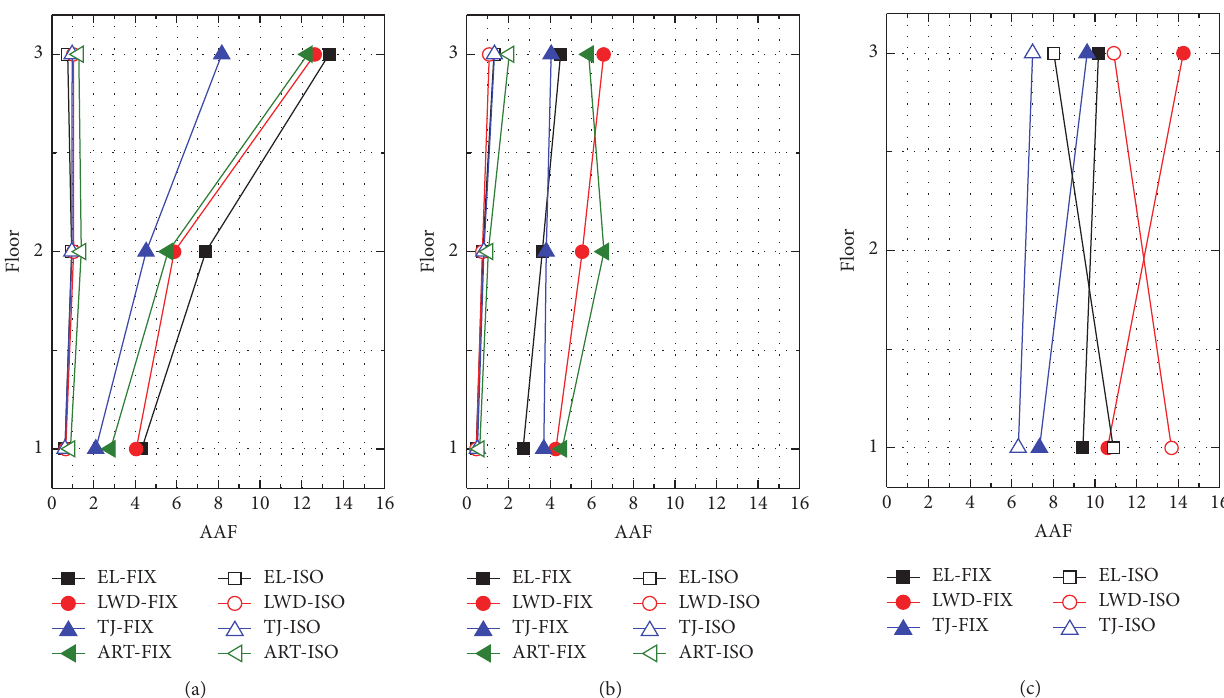
Figure 18: Comparisons on profiles of “Treasures fill the house” AAFs for the isolated and fixed structure under minor earthquake: (a) direction x ; (b) direction y ; and (c) direction z .